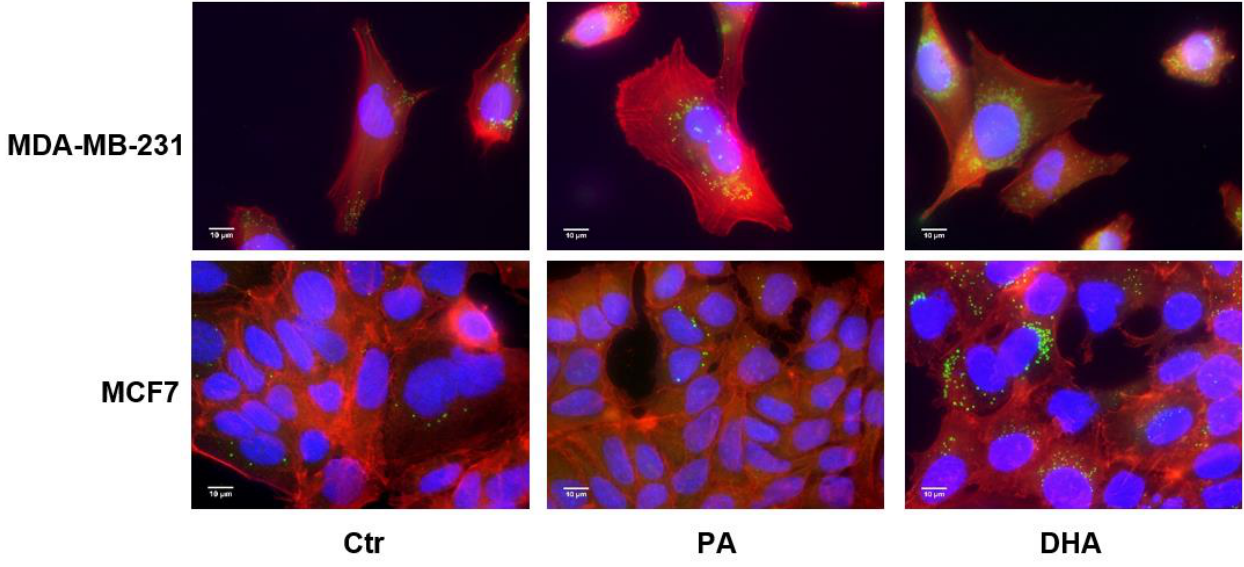
Figure 3. Immunofluorescence analysis of lipid droplets in estrogen-sensitive breast cancer cells MCF7 (Luminal A) and estrogen-insensitive MDA-MB-231 (basal-Like and triple-negative breast cancer (TNBC)) following treatment with PA or DHA (50 μM) for 72 h: 4′,6 -diamidino-2-phenylindole (DAPI) (nucleus in blue), Bodipy (lipid droplet in green), and phalloidin (cytoskeleton in red).